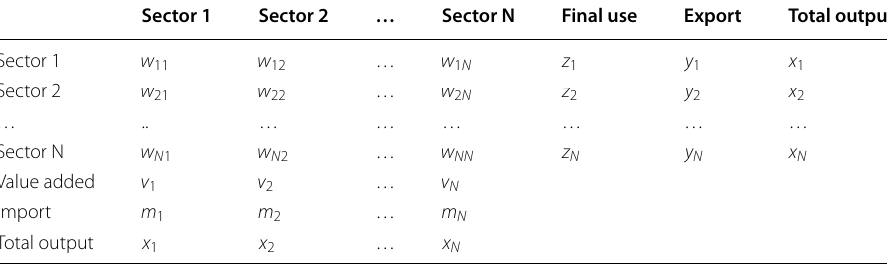
Table 1 A schematic domestic production (input–output)